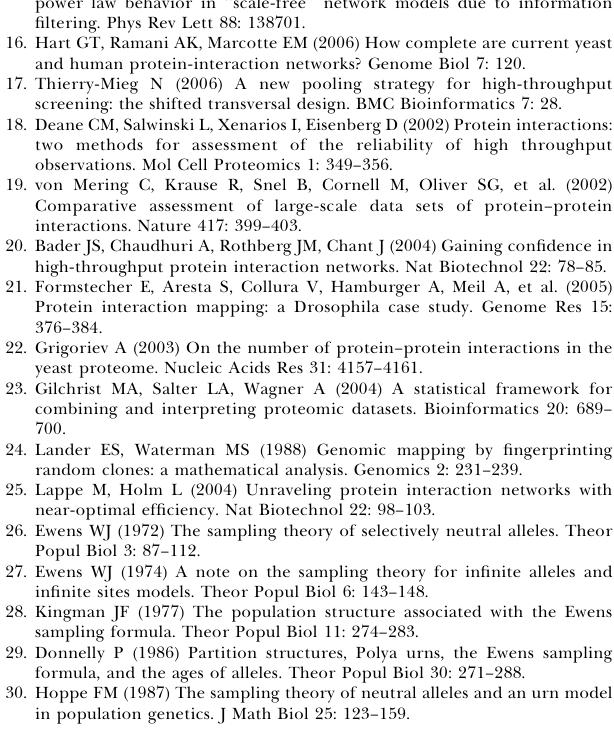
Figure S1. Parameter Estimates for Simulated Datasets Using N ¼ 1,000 Bait Proteins; n ¼ 10 Preys Sampled per Bait; Erdo¨s-Re´nyi Protein Degree Distributions with Mean Degree k ; and SCALED (Top), SINGLE (Middle), and MIXTURE (Bottom) Error Models The MIXTURE error model has two components with population fractions p (1) and p (2) ¼ 1 (cid:2) p (1) and false-discovery rates a (1) and a (2). Estimated parameter values are depicted for three independent trials. Figure S2. Same as Figure S1 but for Power Law Degree Distributions with Power Law Exponent e Found at doi:10.1371/journal.pcbi.0030214.sg002 (71 KB PDF). Figure S3. Same as Figure S1 but for Truncated Power Law Degree Distributions with Power Law Exponent e and Exponential Decay c Found at doi:10.1371/journal.pcbi.0030214.sg003 (55 KB PDF). Figure S4. Estimated Values of Hidden Variables Compared to Known Values for the Bait Degree k (Left), Number of False-Positive Preys f (Middle), and Mixture Model Error Component z (Right) for a Dataset Simulated Using Parameters Obtained from a Truncated Power Law, Mixture Model Fit of the Fly Experimental Data Found at doi:10.1371/journal.pcbi.0030214.sg004 (117 KB PDF). Figure S5. Cumulative Degree Distributions Displayed for the Raw Number w of Unique Interaction Partners; the Estimated Number ˆ j from Equation 19; and from a Previous Estimator ˆ j ˙ [22] The steps observed in ˆ j are from baits with n ¼ w ¼ s , with values provided in Table S6. Found at doi:10.1371/journal.pcbi.0030214.sg005 (70 KB PDF). Table S1. Parameter Value Ranges and RMS and R 2 for Parameter Estimates Are Provided for Simulated Datasets Table S2. BIC Scores Obtained by Simulating Datasets by Each of Nine Generative Models and Calculating the Likelihood of Each Dataset under the Same Nine Models Degree distributions are Erdo¨s-Re´nyi (ER), power law (PL), and truncated power law (TPL). Error models are scaled a (SCALED), single a (SINGLE), and a two-component mixture (MIXTURE).